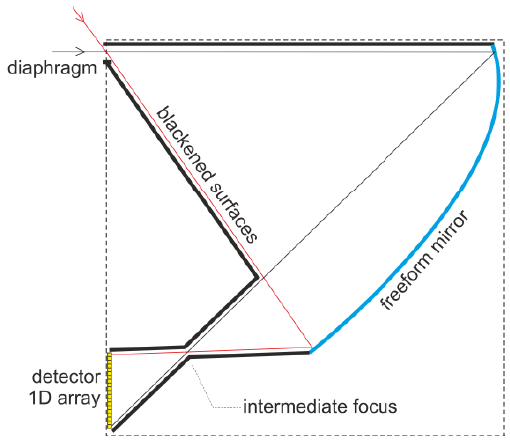
Figure 7. Configuration with an intermediate focus on minimizing stray light.